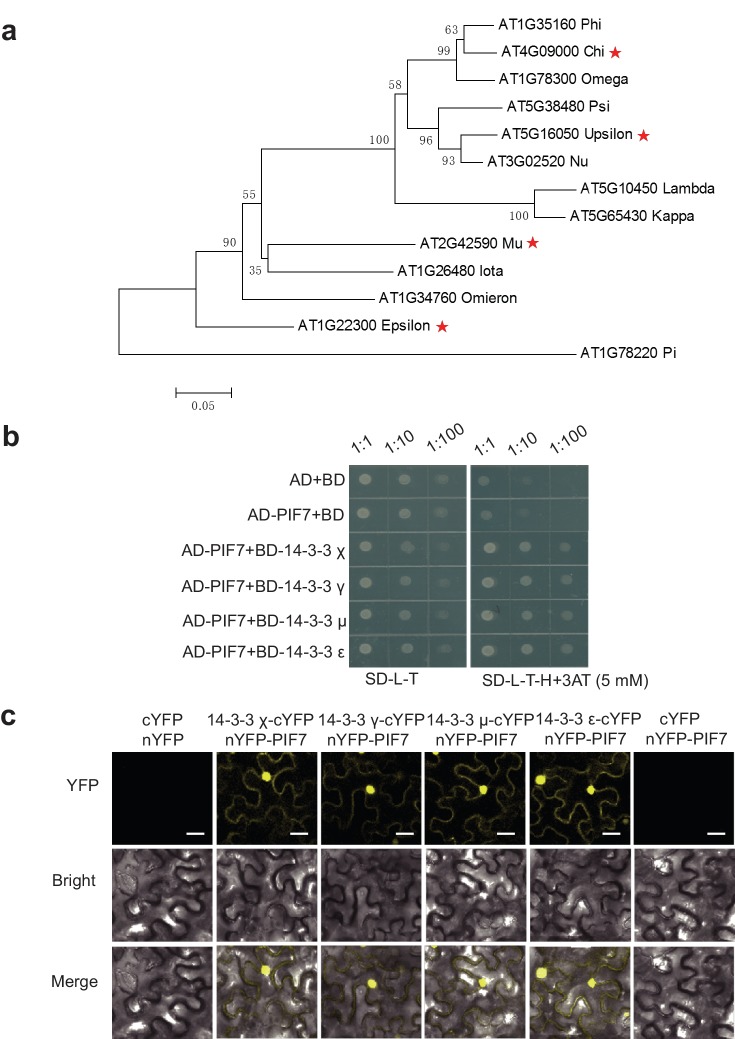
PIF7 can interact with 14-3-3 χ, γ, μ and ε proteins.(a) Phylogenic tree of 14-3-3 proteins in Arabidopsis. The tree was generated using predicted full-length amino acid sequences and neighbor-joining in MEGA5. The numbers on the nodes indicate the confidence values when 1000 replications were used. The positions of 14-3-3 χ, γ, μ and ε are marked by red stars. (b) PIF7 interacts with 14-3-3 χ, γ, μ and ε in a yeast two-hybrid assay. Each yeast clone containing the pGADT7 (AD) or pGADT7-PIF7 (AD-PIF7), together with pGBKT7 (BD) or pGBKT7-14-3-3 χ, γ, μ or ε (BD-14-3-3 χ, γ, μ or ε), was grown on transformation selection (SD-L-T) or interaction selection (SD-L-T-H+3AT) plates. Dilution of the inoculation is shown at the top of the picture. (c) Interaction between PIF7 and 14-3-3 χ, γ, μ or ε detected by BiFC. The C-terminal half of YFP was fused to 14-3-3 χ, γ, μ or ε and N-terminal half of YFP was fused to PIF7. The constructs were co-transformed into tobacco leaf cells, and fluorescence images were obtained by confocal microscopy. White scale bar represents 75 μm.